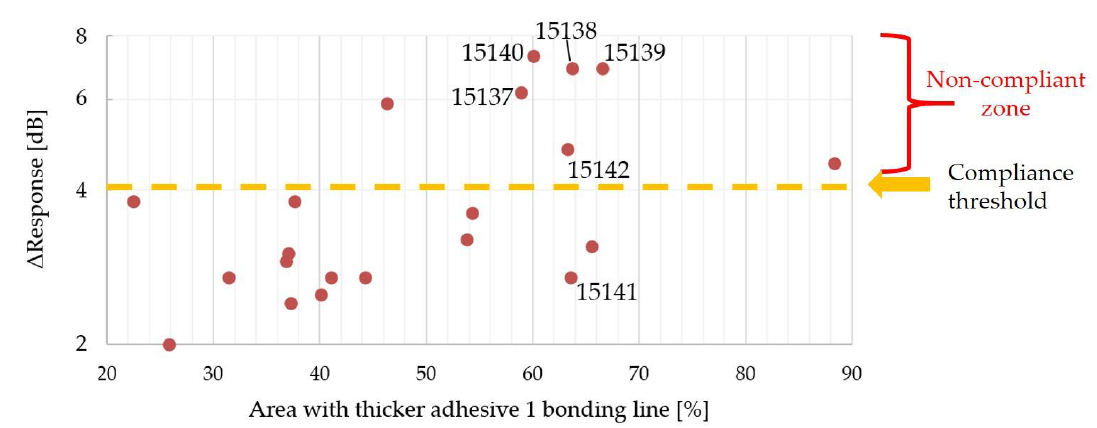
Figure 15. ∆ Response versus area with thicker adhesive 1 bonding Figure 15. ΔResponse versus area with thicker adhesive 1 bonding line. Figure 15. ΔResponse versus area with thicker adhesive 1 bonding line.